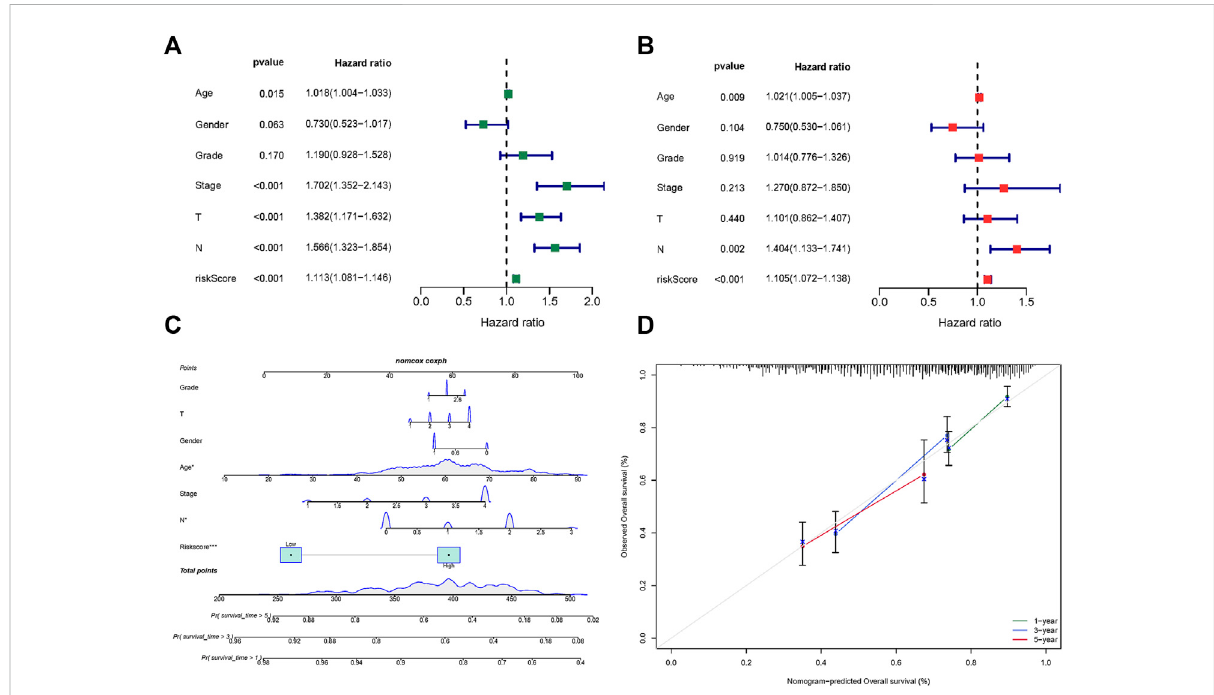
FIGURE 4 Riskscorebasedfattyacidmetabolism-relatedmicroRNAs. (A) UnivariateCoxanalysisofriskfactors. (B) MultivariateCoxanalysisofriskfactors. (C) The nomogram integrated the risk score, age, gender, grade, and stage to predict OS. (D) The calibration curves for